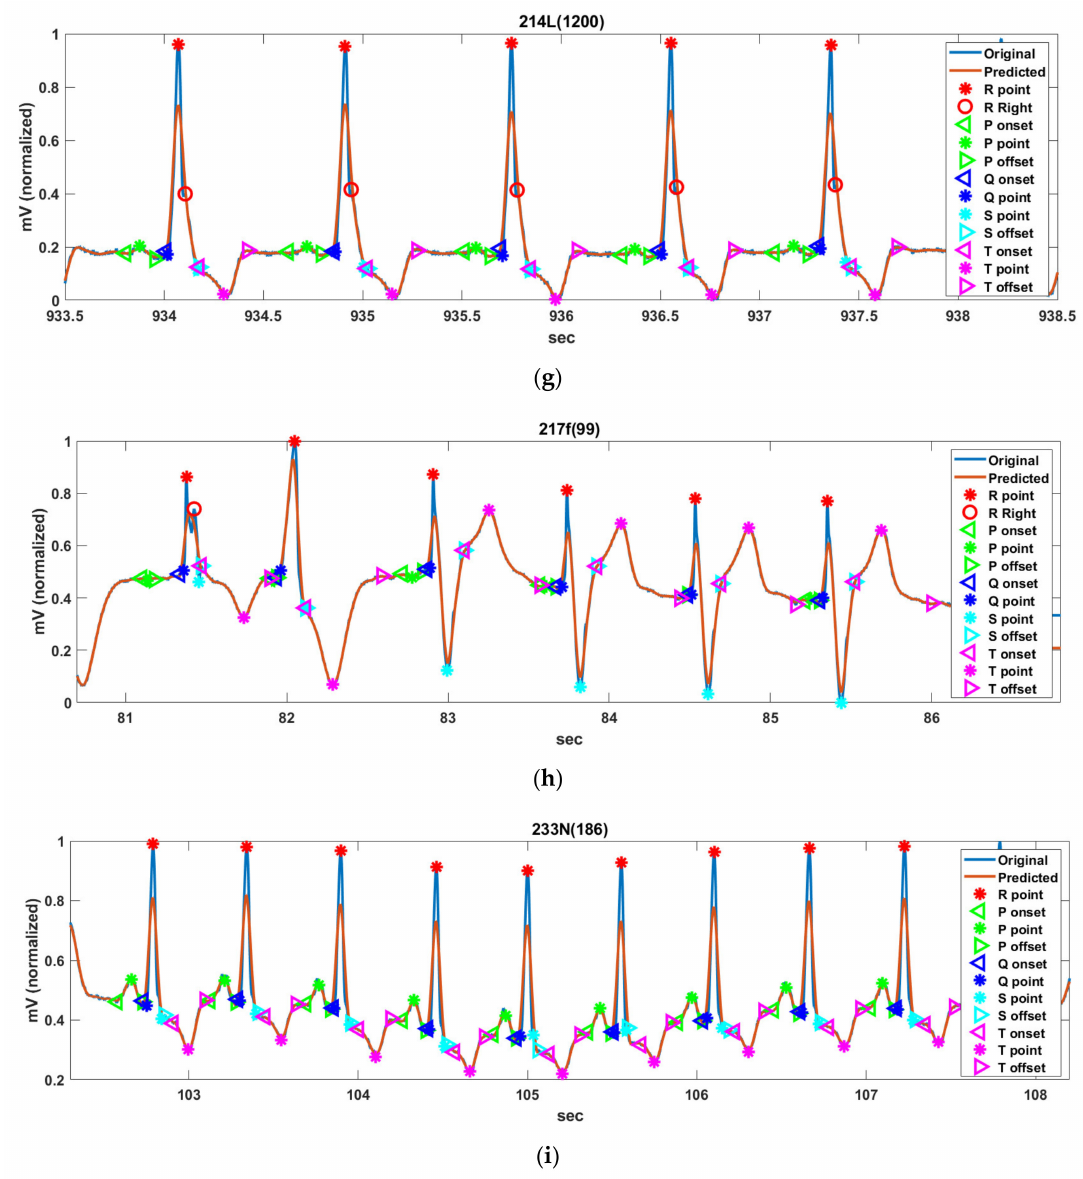
Figure 13. Detection result of the PQRST FPs for Record ( a ) 106V(497), ( b ) 108N(6), ( c ) 118R(159), ( d ) 201x(608), ( e ) 202a(1415), ( f ) 202N(806), ( g ) 214L(1200), ( h ) 217f(99), and ( i ) 233N(186) sample in